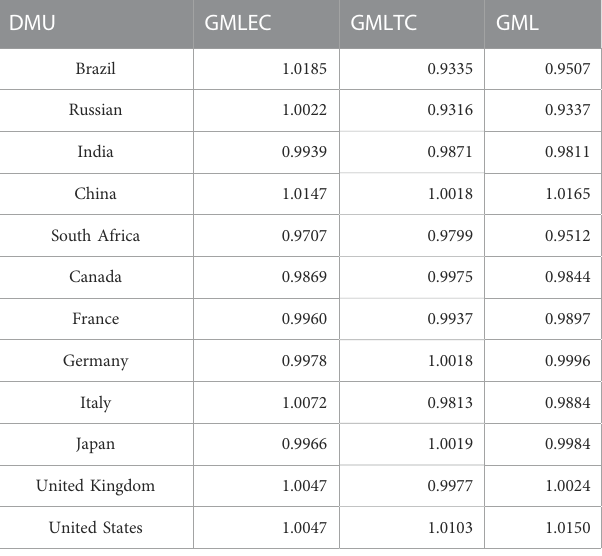
TABLE 4 Changes and decomposition of BRICS and G7 sustainable total factor